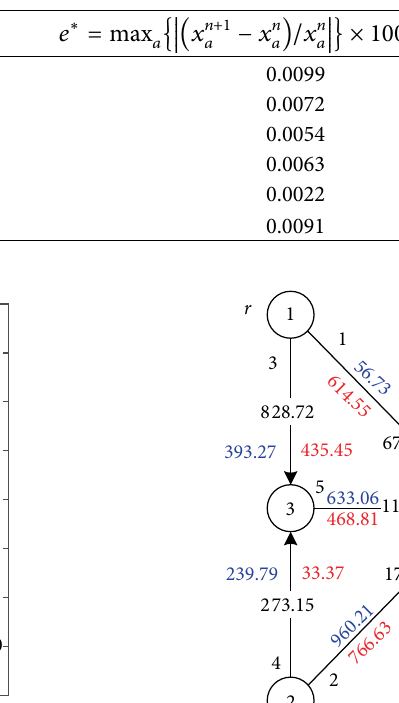
Table 8: Summary of iterations of the SDA.